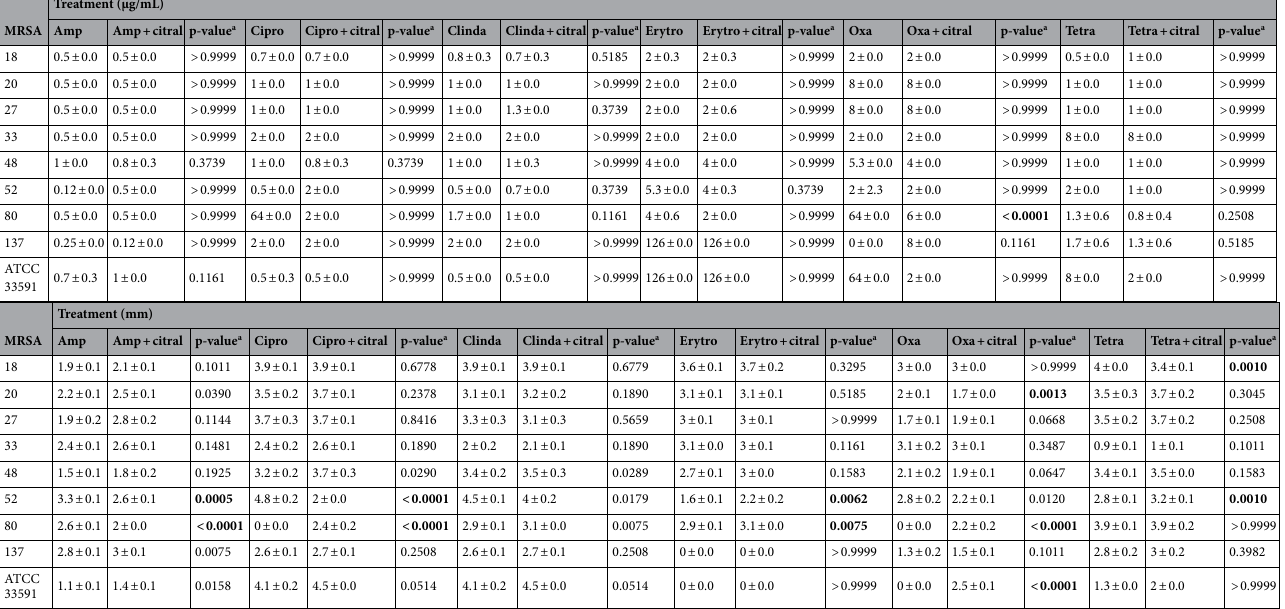
Table 2. Average of triplicate with three independent repetitions of inhibition zone (mm) values and MIC (μg/mL) values for antibacterial modulating activity of citral 5 mg/mL (0.5%) on antibiotics ampicillin (Amp), ciprofloxacin (Cipro), clindamycin (Clinda), erythromycin (Ery), oxacillin (Oxa), tetracycline (Tet) on MRSA (18, 20, 27, 33, 48, 52, 80, 137) and ATCC 33591 strains. a Mann–Whitney one-tailed test was used. Bold: data with statistical significance.